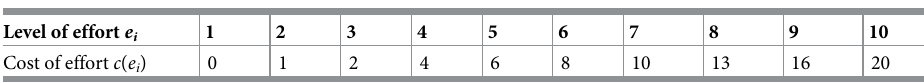
Table 1. Costs of